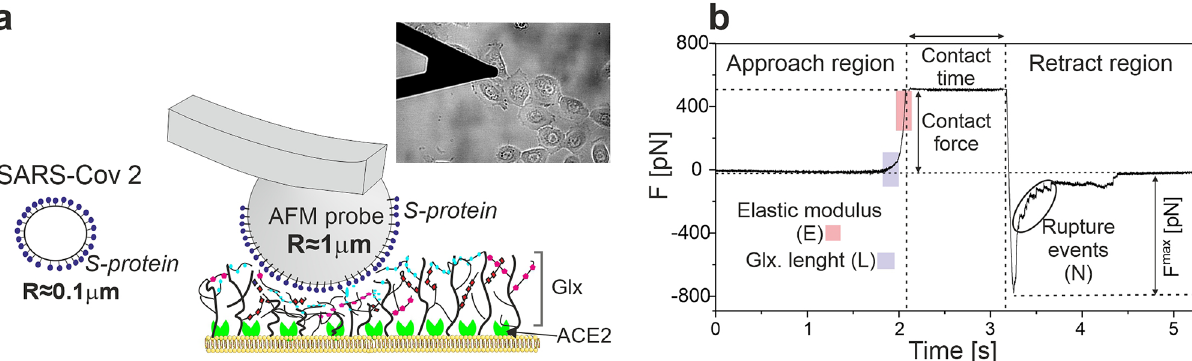
Figure 2. Experimental design and characterization of studied HBEC and HPAEC cells. ( a ) The idea of the experimental setup. Multiple spike proteins are attached to a large spherical AFM probe that is approached to the cell surface. Inset: Optical image of the experimental setup with a spherical probe. The AFM cantilever with a probe and HBEC cells on the glass are immersed in the HBSS solution. ( b ) Time diagram of recording a single force-distance curve with the approach, contact and retract regions. In the approach part, regions of curves taken for analysis of glycocalyx parameters (blue) and cell elasticity (red) are schematically marked. The maximal de-adhesive force and rupture events are marked on the retracting part of the curve. Figure created with OriginPro2021 (https:// www. origi nlab. com/ 2021) and Corel Draw2020 (https:// www. corel draw. com/